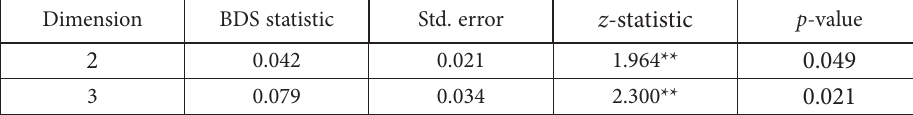
Table 12. BDS test results for Tax = f ( GDP, FD, FD 2 ) Dimension